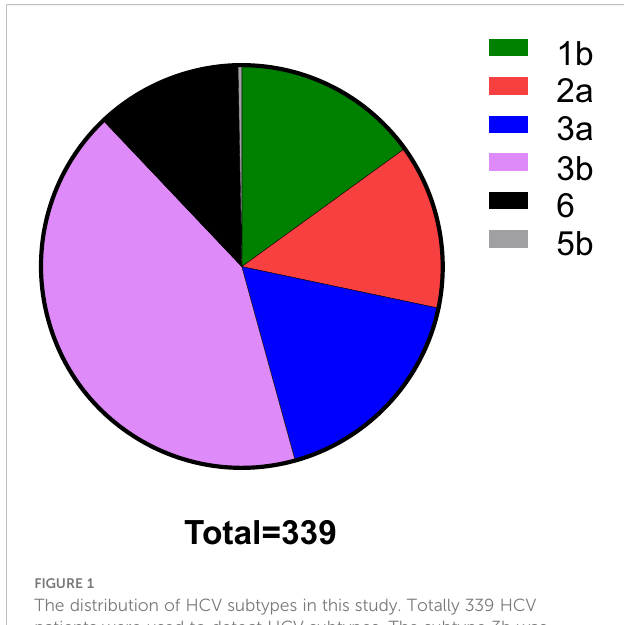
FIGURE 1 The distribution of HCV subtypes in this study. Totally 339 HCV patients were used to detect HCV subtypes. The subtype 3b was dominant in Yunnan Province.